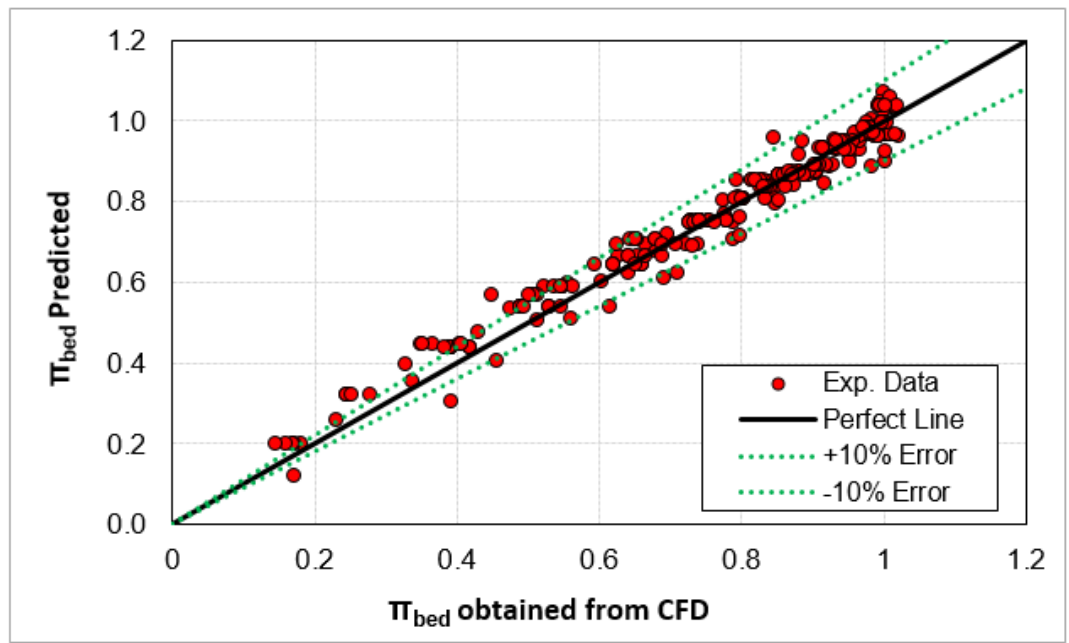
Figure 10. Dimensionless bed shear stress correlation predicted vs. CFD for conditions [0.25 ≤ κ ≤ 0.75, e = 0.9 and Q = 5 × 10 − 5 m 3 /s].